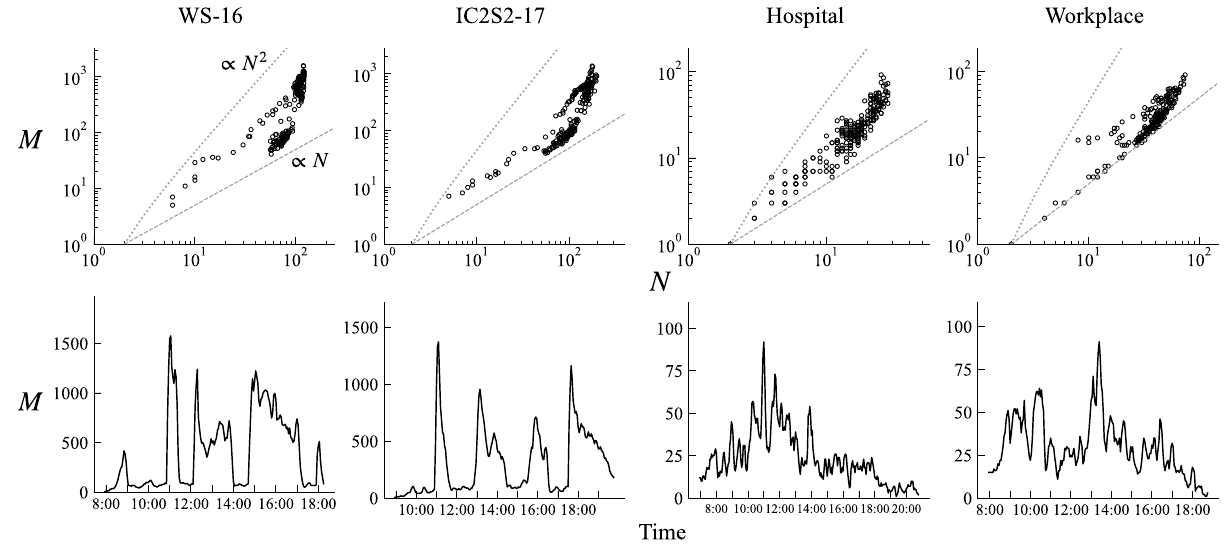
Figure 1. Dynamical behaviour of number of active nodes N and number of active edges M . In upper panels, dynamical relationship between N and M is shown. Each dot represents a snapshot network created over a 10-min time window. Gray dashed and dotted lines respectively denote N /2 (i.e., the lower bound for M ) and 1 )/ 2 (i.e., the upper bound for M ). Lower panels show the behaviour of M over N ( N −